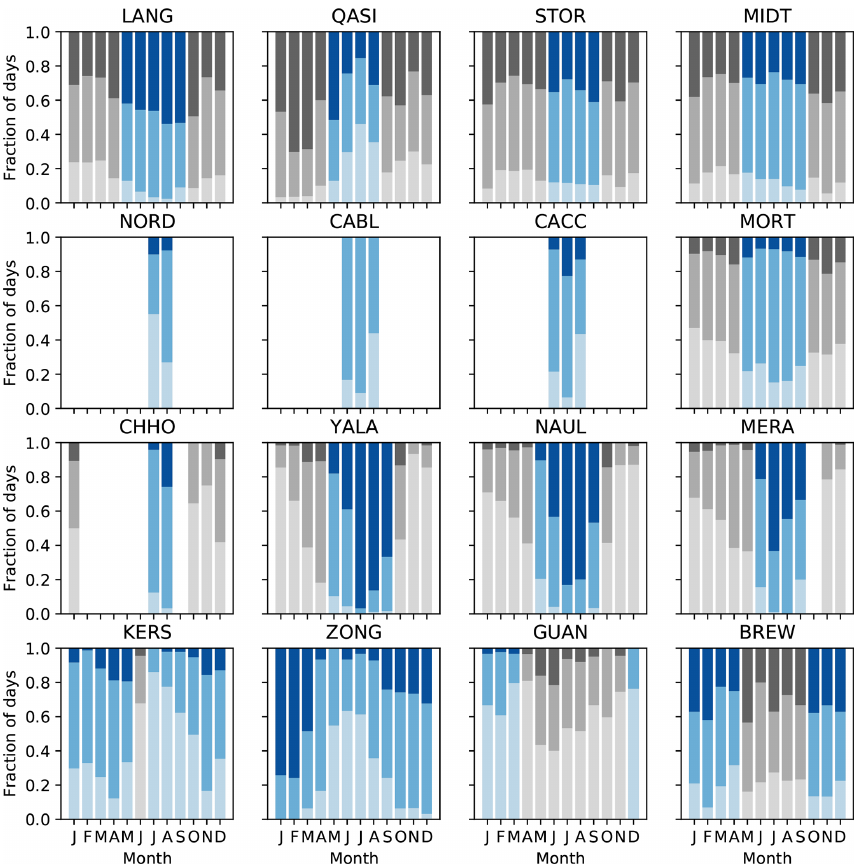
Figure 5. Monthly fraction of clear-sky (light shading), partially cloudy (mid shading) and overcast conditions (dark shading) defined using daily average cloudiness ( N ε ). Months defined as within the melt season are shaded